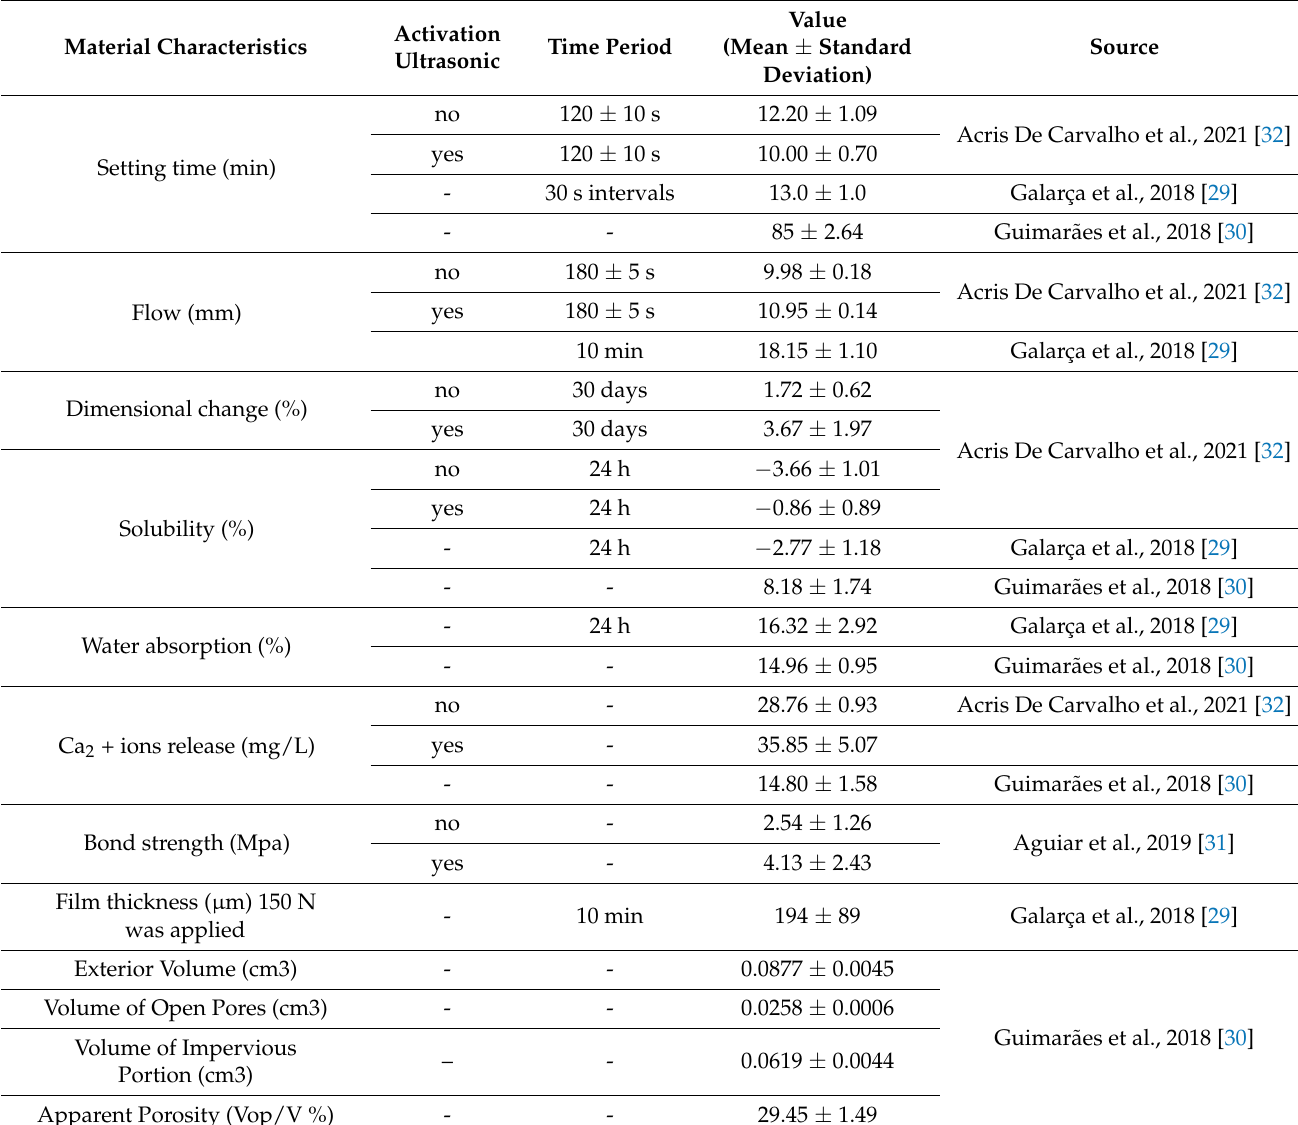
Table 6. Selected physicochemical parameters of the MTA